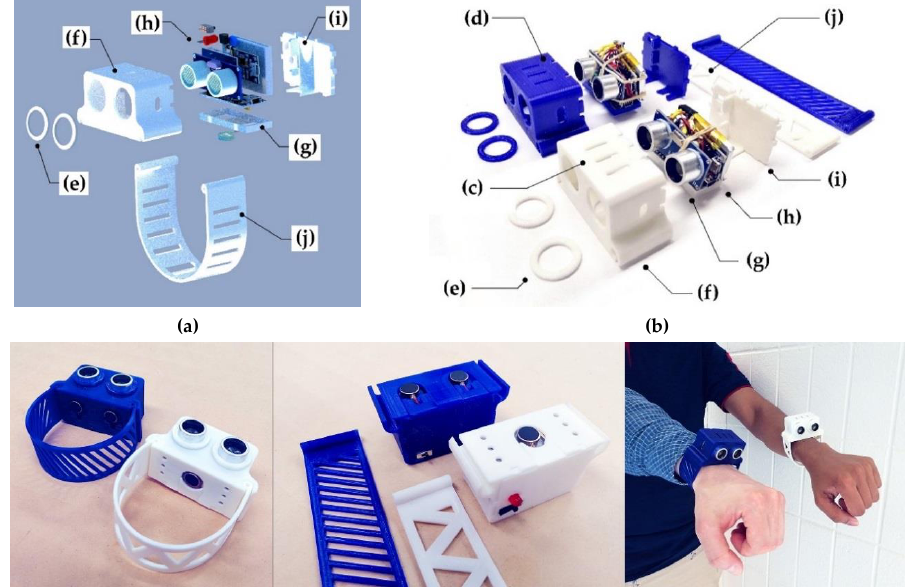
Figure 1. Parts of an open-source navigational support with 3-D printable case components: ( a ) 3-D prototype; ( b ) Components; ( c ) Model 1 with one vibration motor; ( d ) Model 2 with two vibration motors; ( e ) Locking rings; ( f ) Case; ( g ) Vibration pad; ( h ) Sensor core; ( i ) Back cap; ( j ) Bracelet; ( k ) Assembly.